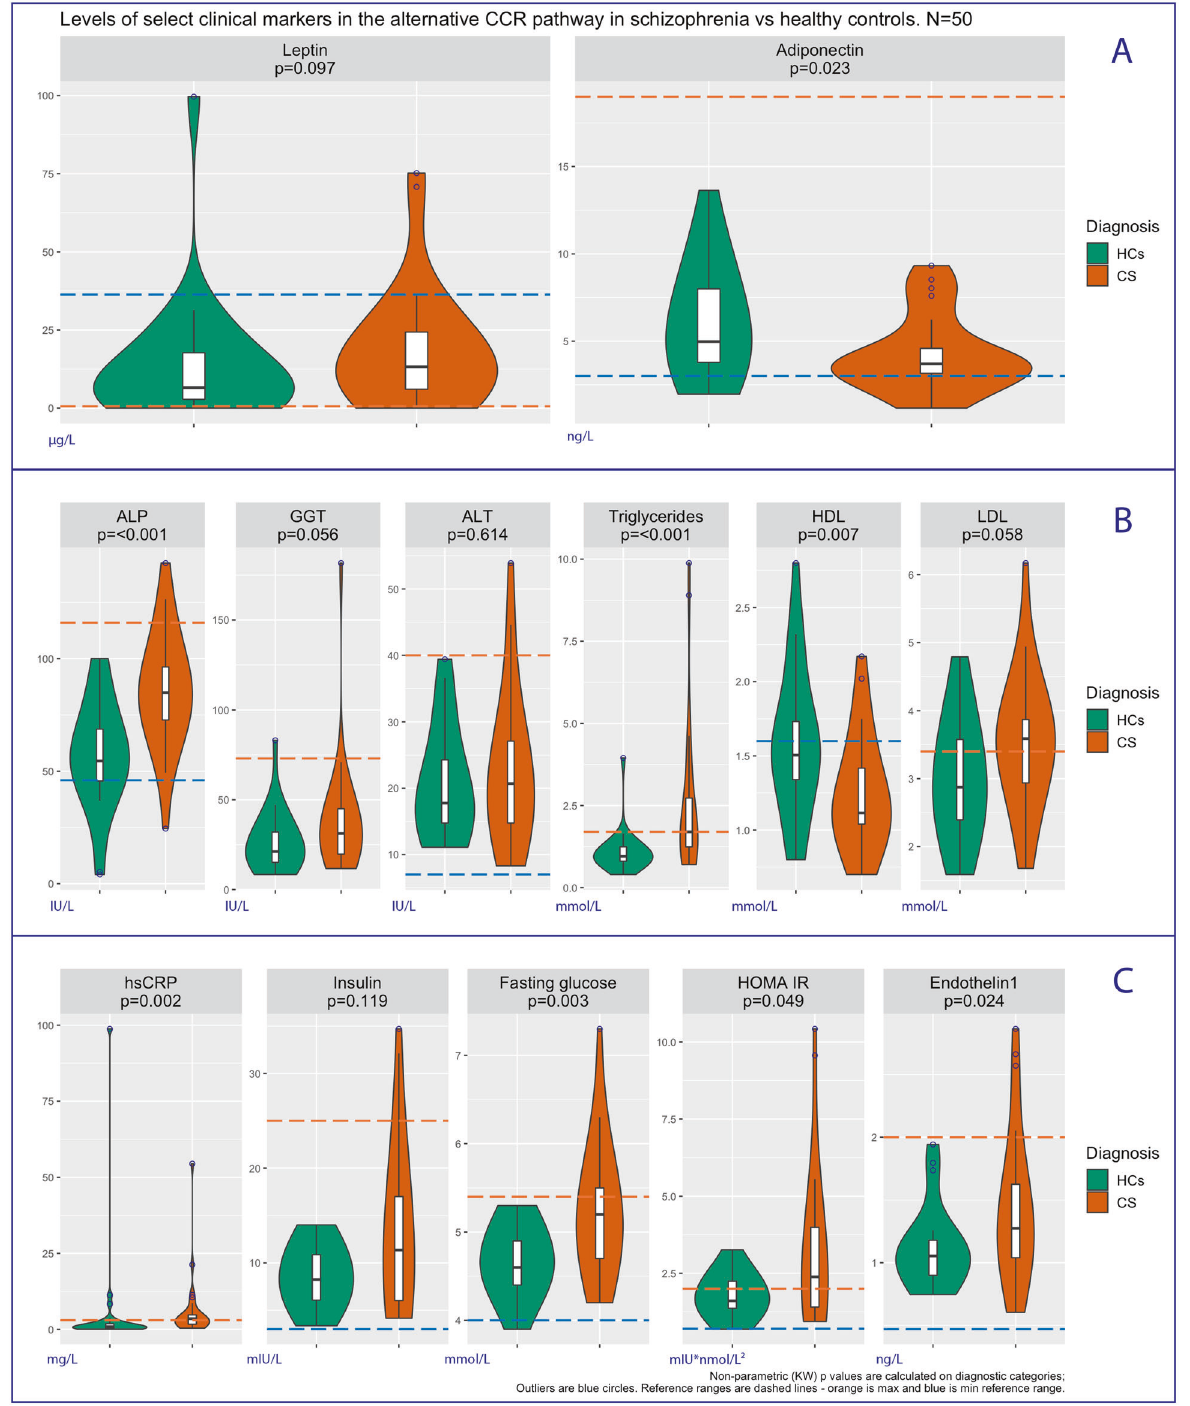
Fig. 3 Concentric cardiac remodelling non-hypertensive pathway activity in schizophrenia vs healthy controls. A Markers of adipocyte dysfunction. B Markers of dyslipidaemia or liver dysfunction (e.g. NAFLD). C Markers of in fl ammation, dysglycaemia, and endothelial dysfunction. p Kruskal – Wallis non-parametric test p value, HC healthy control, CS chronic schizophrenia, ALP alkaline phosphatase, GGT gamma-glutamyltransferase, ALT alanine aminotransferase, LDL and HDL low- and high-density lipoprotein, hsCRP high-sensitivity C-reactive protein, HOMA-IR Homeostatic Model Assessment for Insulin age- and BMI-adjusted control subjects [39], and high adiponectin cytokines, which further inhibit the production of adiponectin in levels are associated with lower risk of CAD in healthy men [40]. adipocytes. Adiponectin expression by adipocytes is also inhibited Finally, adiponectin reductions are associated with increased CRP by oxidant stress [38]. Adiponectin levels are strongly negatively and other pro-in fl ammatory cytokines [18, 19], insulin resistance correlated with CVD: adiponectin concentrations in the plasma are [19], elevated plasma triglycerides and lipoproteins [20], and reduced in coronary artery disease (CAD) patients, compared to